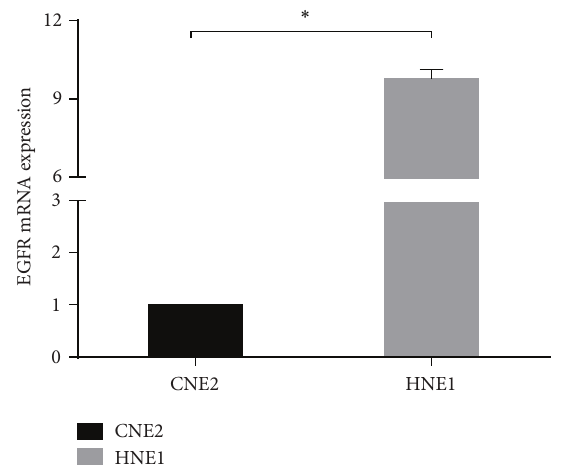
Figure 3: Relative levels of EGFR mRNA expression in NPC cell lines (CNE2, HNE1), as determined by qRT-PCR analysis. ∗ 𝑝 < 0.05 versus CNE2.